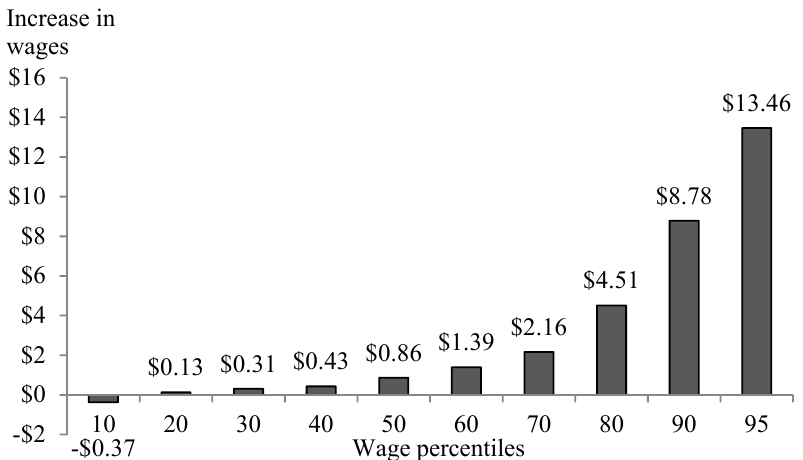
Figure 2. Growing Wage Inequality: Change in Hourly Wages by Wage Percentile, 1979–2011 (2011 Dollars). Source: Calculated from data presented in “Hourly wages of all workers, by wage percentile, 1973–2011” (Mishel et al. 2012, p. 186).